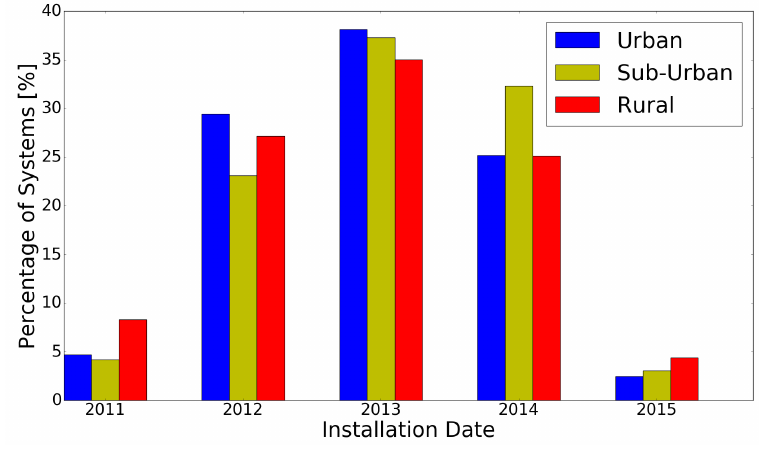
Figure 2. Installation date